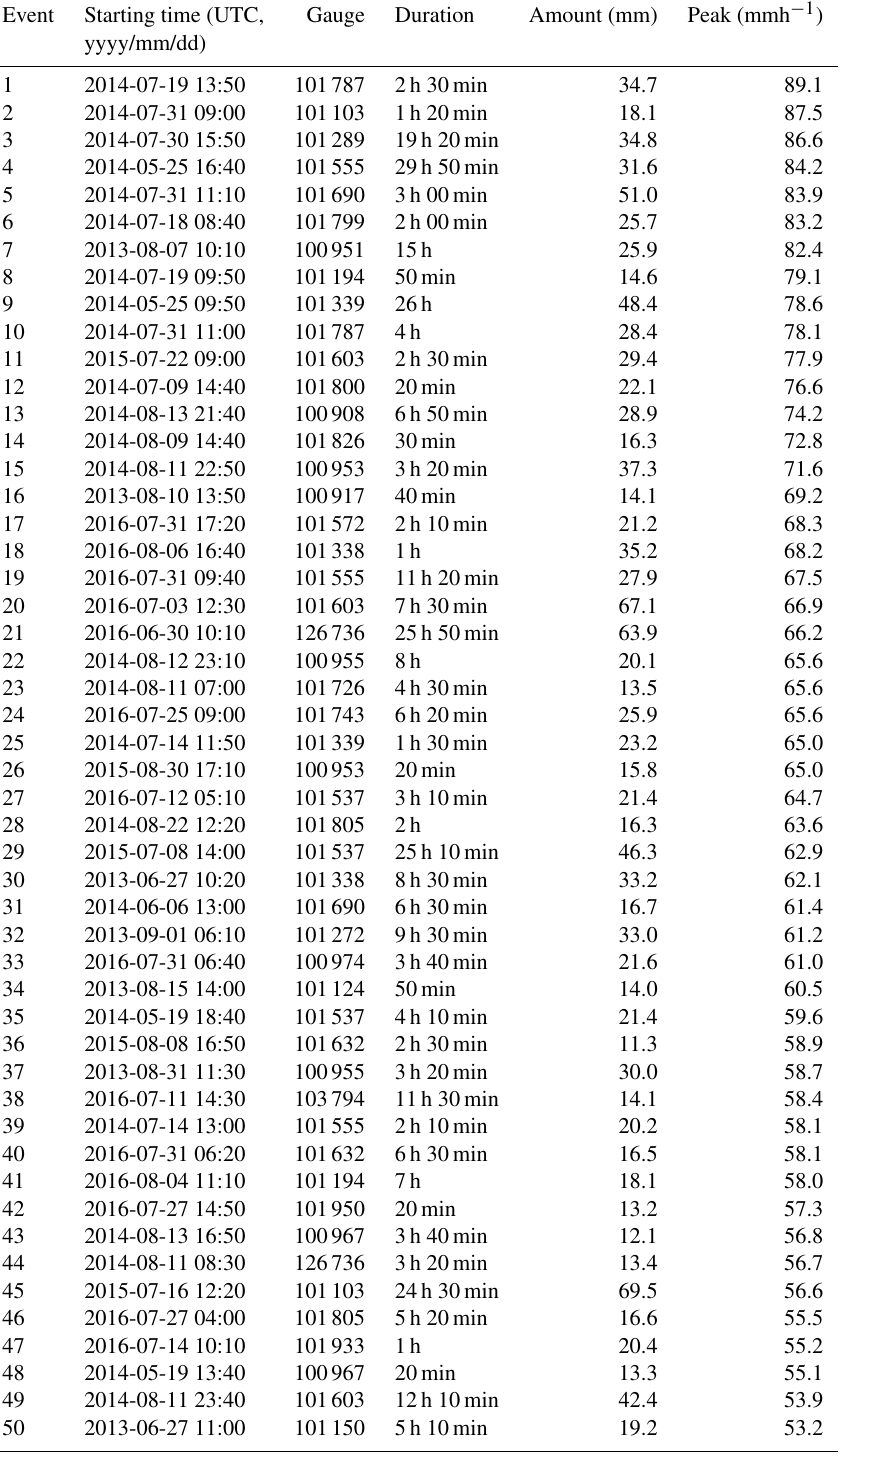
Table A3. Top 50 events for